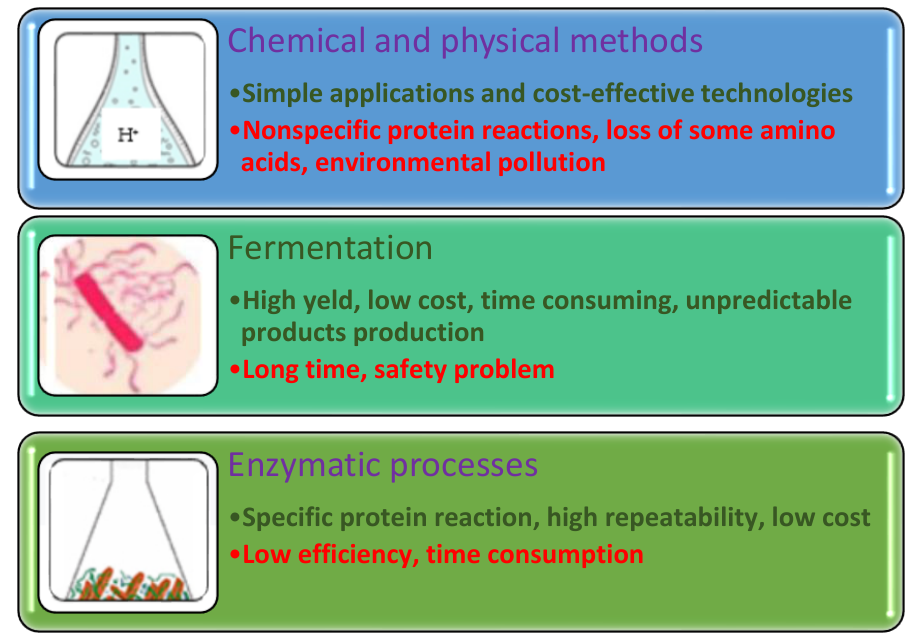
Figure 2. Natural source pretreatments to prepare peptides. Advantages are shown in green. Disad- vantages are given in red.